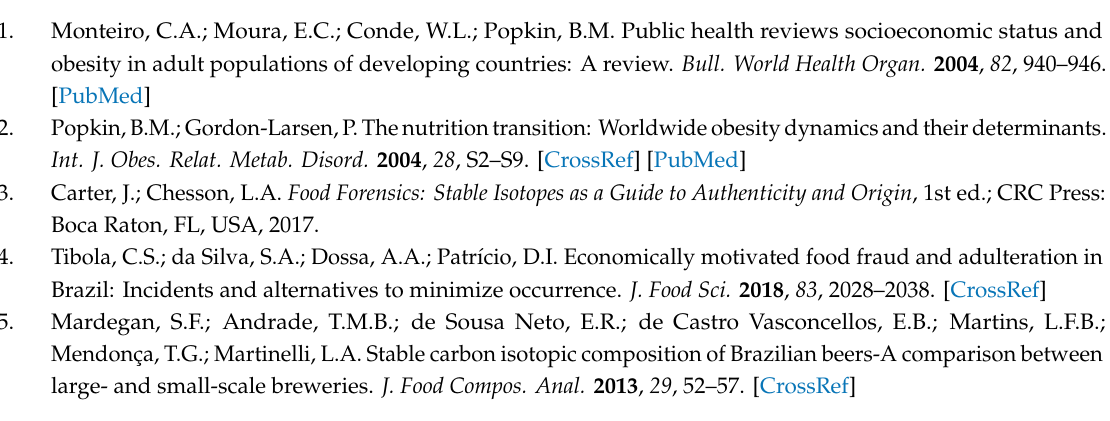
Supplementary Materials: Spreadsheet: δ 13 C and δ 15 N values of every single sample of foods and beverages analyzed in this